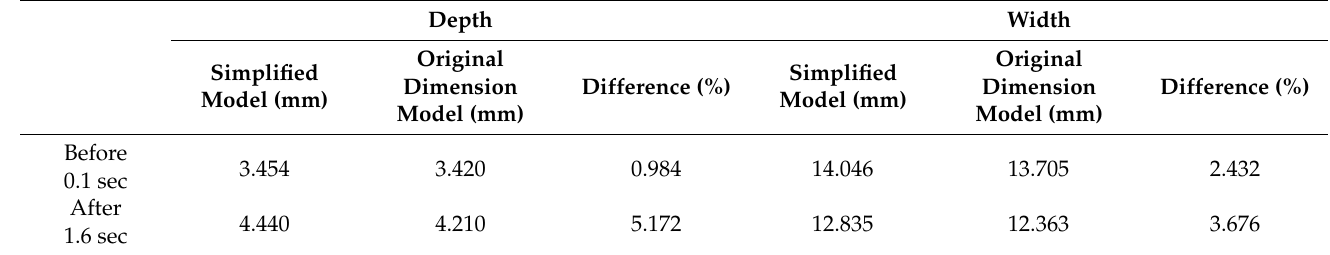
Table 9. Temperature 600 ◦ C line comparison of simplified model and actual